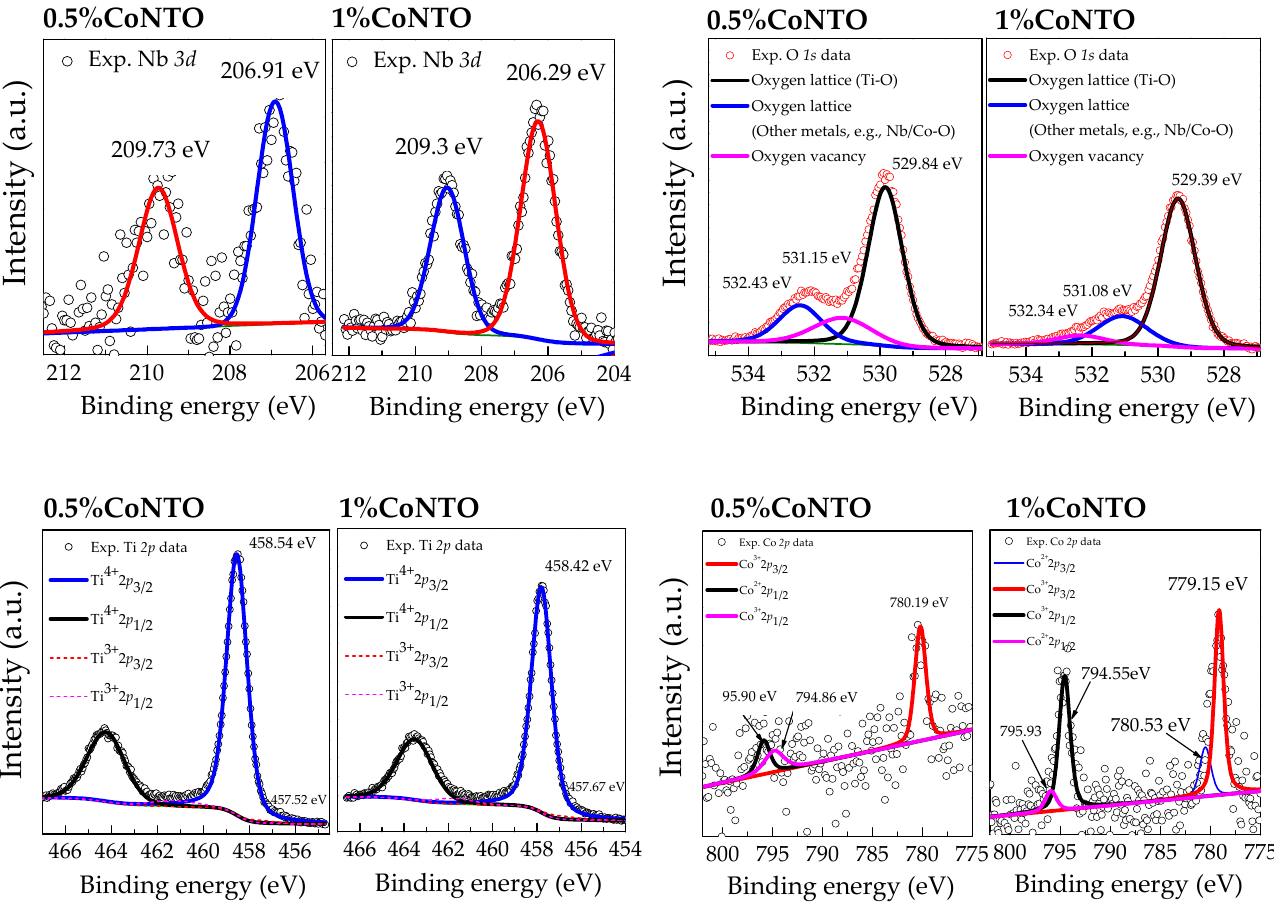
Figure 4. XPS spectra of 0.5% CoNTO and 1% CoNTO ceramics.